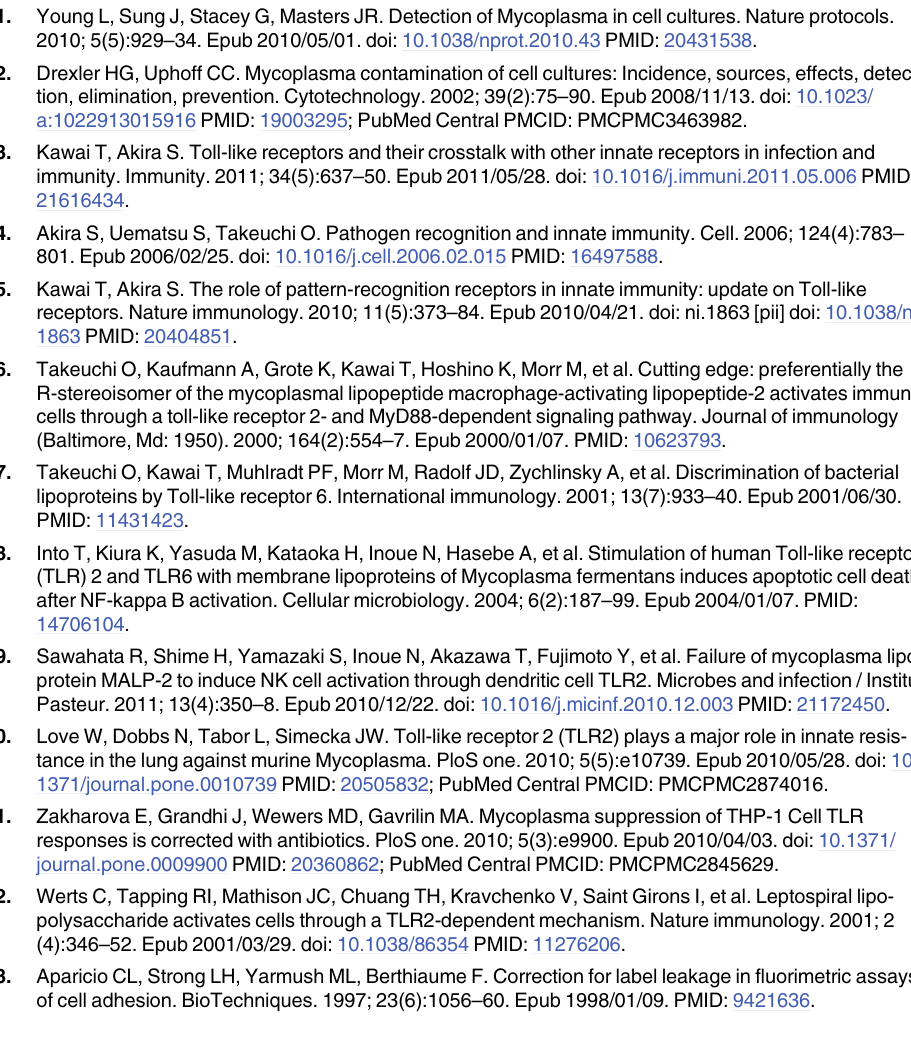
S4 Fig. Proteinase K treatment of B16 cell lysates results in strongly impaired upregulation of IL-6 mRNA levels in bone marrow cells. Bone marrow cells were cultured in the presence of cell lysates from Mycoplasma hyorhinis -infected B16 cells. Some B16 cell lysates were pre- treated with proteinase K. 18 h later, IL-6 mRNA levels in the bone marrow cells were deter- mined by quantitative real-time PCR. Data give the mean values of at least triplicate samples + S.E.M. and are expressed as expression relative to actin